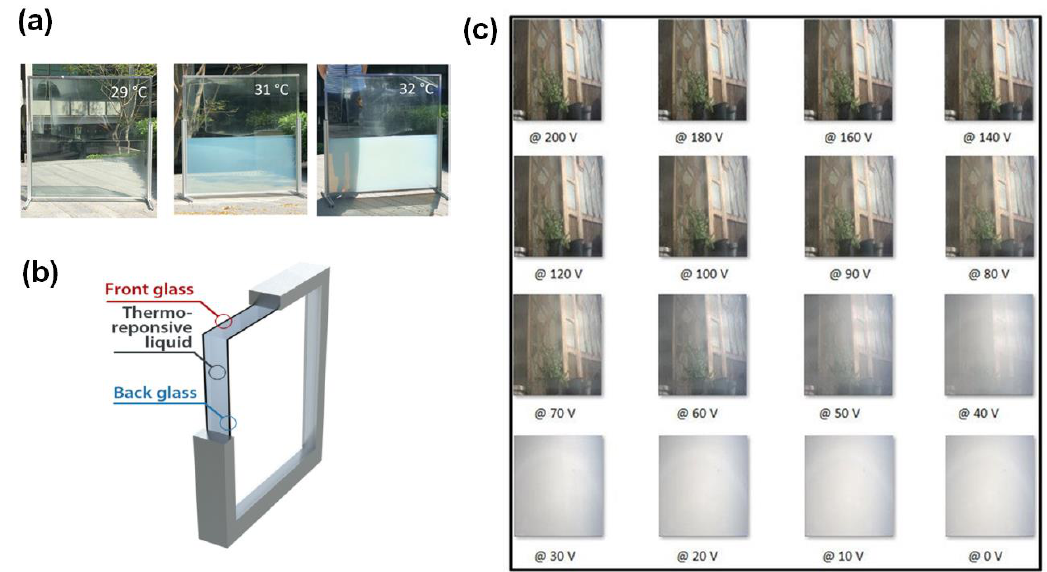
Figure 5. ( a ) Photograph of smart thermoresponsive glazing and corresponding transparencies tested at different temperatures. ( b ) Schematic illustration of the thermoresponsive glazed window adapted with permission from [9]. ( c ) PDLC glazing, for which transparency changes with applied voltages (V), is adapted with permission from [110].